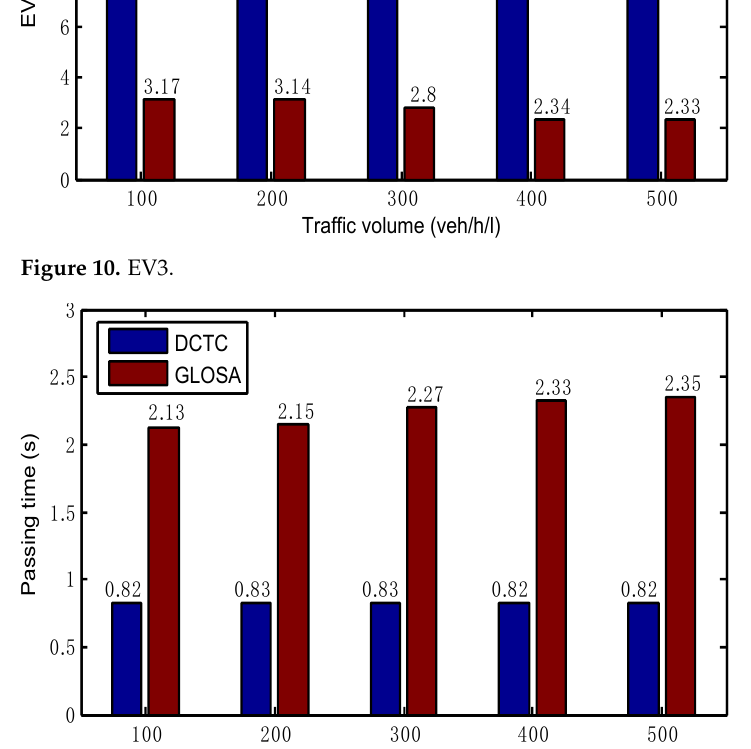
Figure 11. Passing